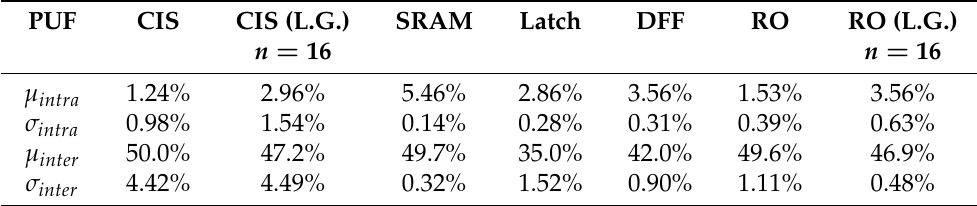
Table 1. Comparison table of intra-HD and inter-HD.